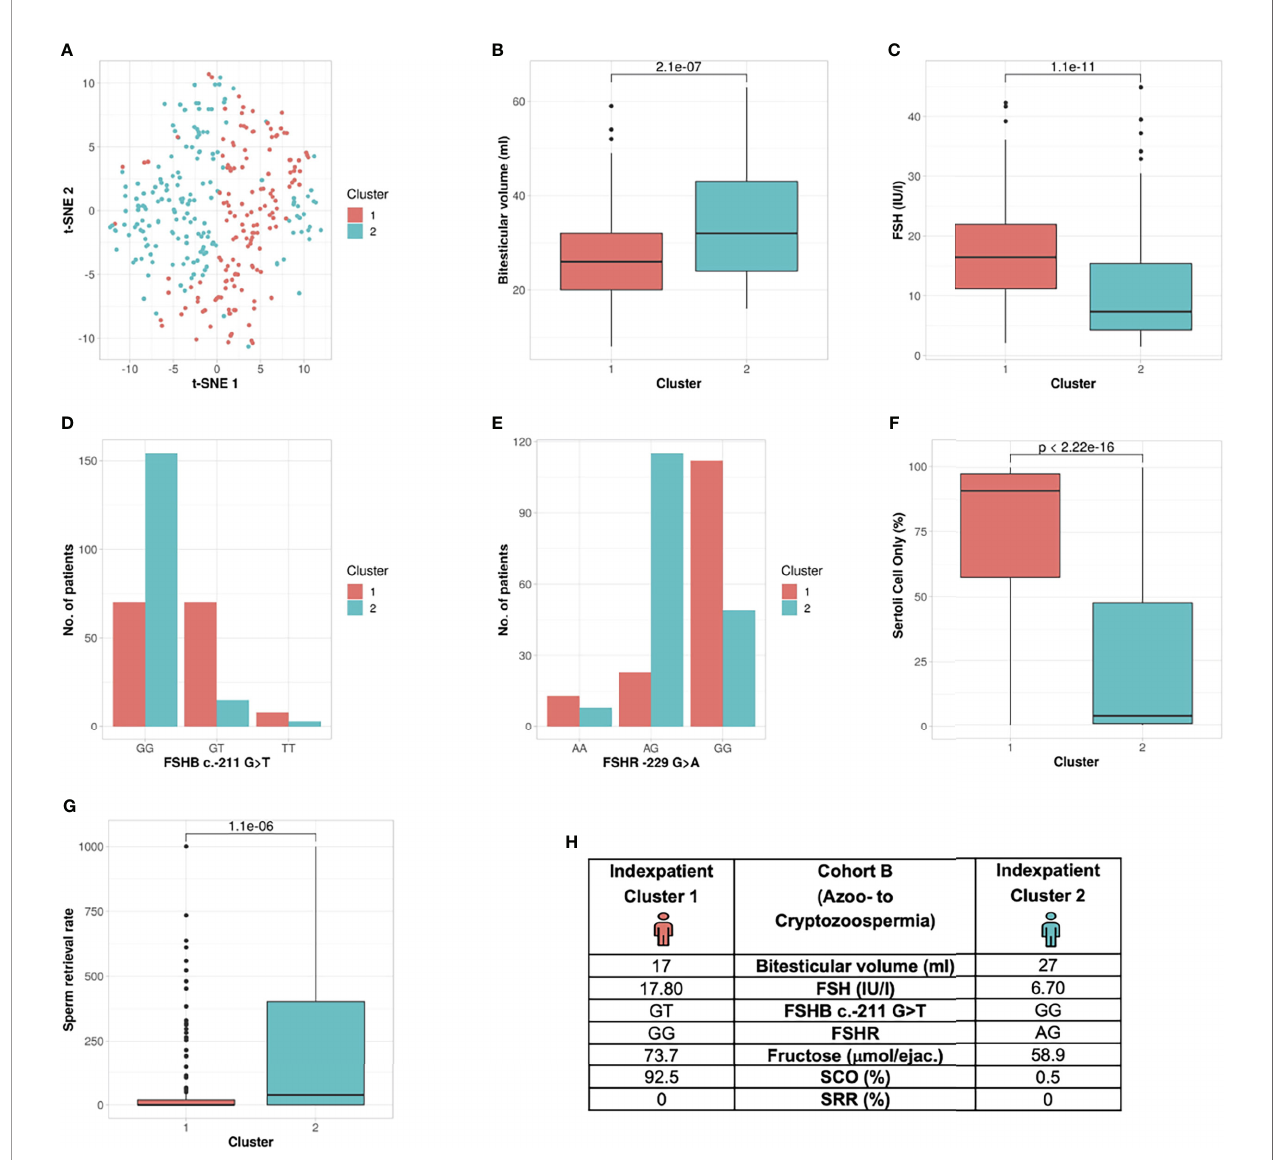
FIGURE 4 | Cluster analysis Cohort B: Identi fi cation of two clusters and six segregation parameters (azoo- to cryptozoospermia). (A) Distribution of patients in the clusters. Each dot represents one patient of the entire cohort (n=320). The distances between the patients are presented in two-dimensional space. Silhouette width is 0.10. (B – G) The andrologic/histologic parameters bi-testicular volume, FSH and FSHB c.-211, FSHR, Sertoli cell only syndrome (SCO) and sperm retrieval rate (SRR) are the signi fi cant segregation markers between the two clusters. The boxes show the fi rst, second (i.e., median) and third quartiles of the respective parameters in Cluster 1 (comprising most individuals with GG) and Cluster 2 (comprising most individuals with a T allele). Outliers are shown as circles above the whiskers. The patients in the clusters differ signi fi cantly in regards to the mentioned seven andrologic parameters. Adjusted p values are located in the plots and range from (p < 2.3e -19 to 2.2e -6 ). (H) Reproductive parameters of the index patient of Cluster 1 and 2. The index patient represents Cluster 1 or 2, respectively, with the parameters in which both clusters differ signi fi cantly. (The presented values do not necessarily match the median or mean of all parameters in the